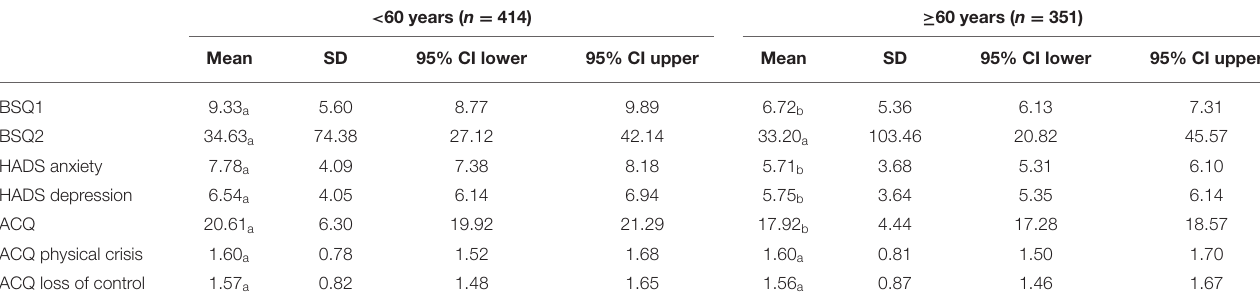
TABLE 2 | Body Sensations Questionnaire (BSQ), Agoraphobic Cognitions Questionnaire (ACQ), and Hospital Anxiety and Depression Scale (HADS) in both age groups.